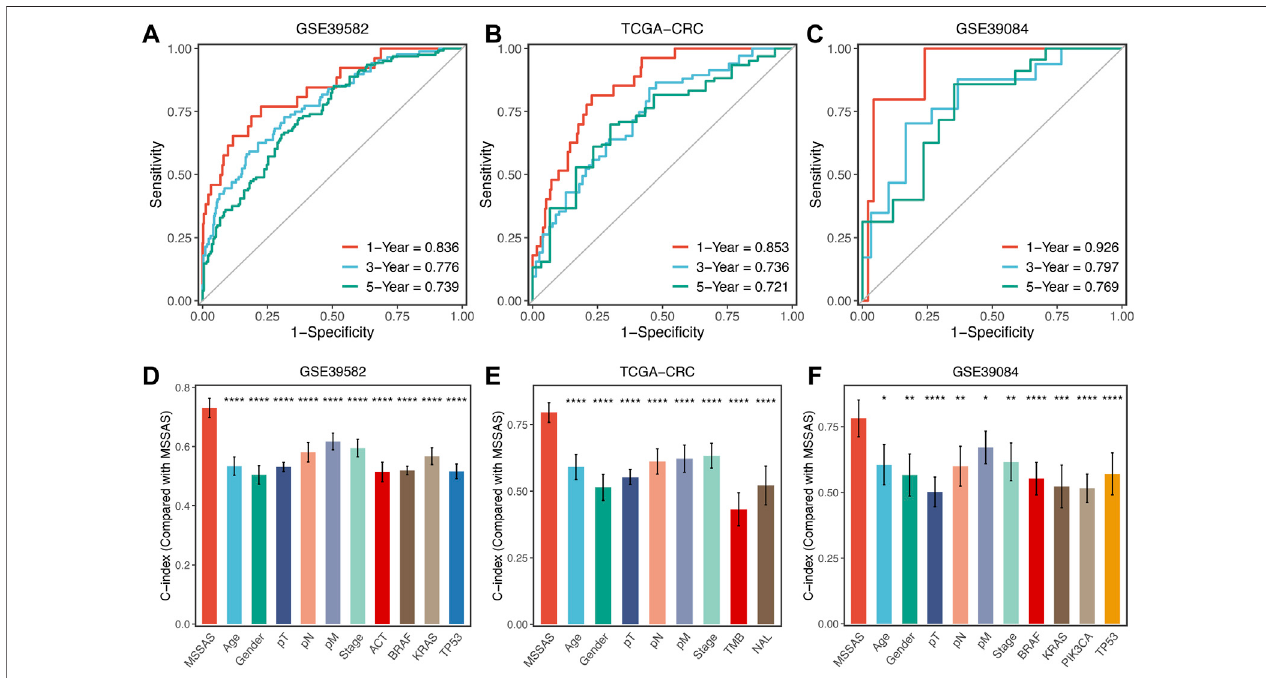
FIGURE 7 | Evaluation of MSSAS in three cohorts. Time-dependent ROC analysis for predicting OS at 1, 3, and 5 years in GSE39582 (A) , TCGA – CRC (B) , and GSE39084 (C) . The performance of MSSAS was compared with common clinical and molecular variables in predicting prognosis across GSE39582 (D) , TCGA-CRC (E) , and GSE39084 (F)